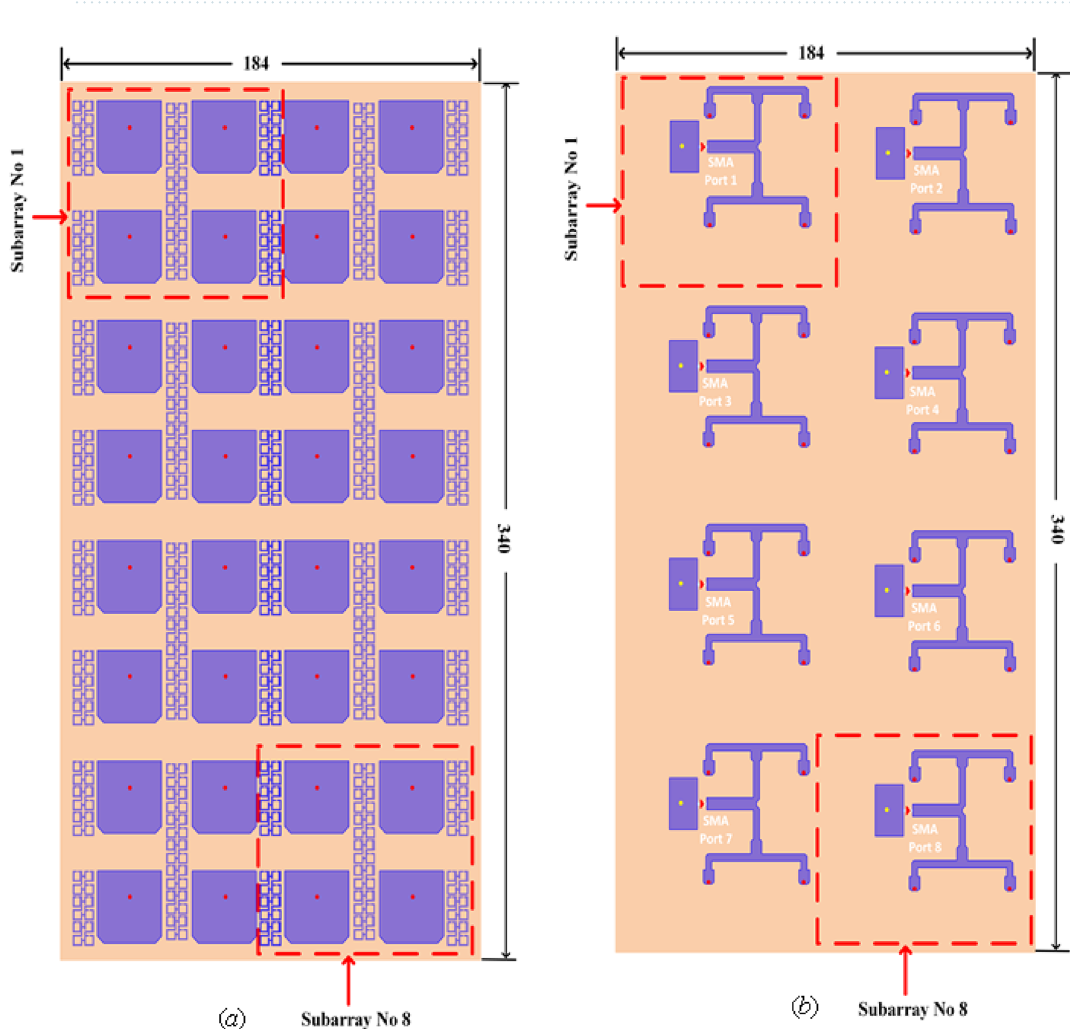
Figure 10. ( a ) Top view of a single side array, ( b ) single side array bottom